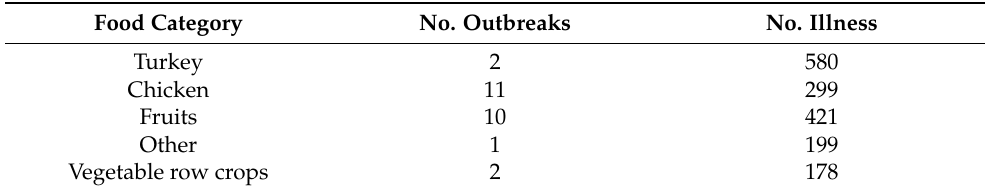
Table 1. Comparison of Salmonella food category pairs and number of outbreaks resulting in illness